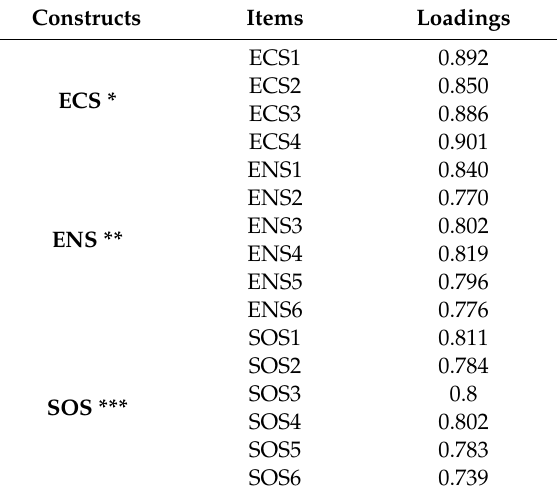
Table 2. Indicator loadings.